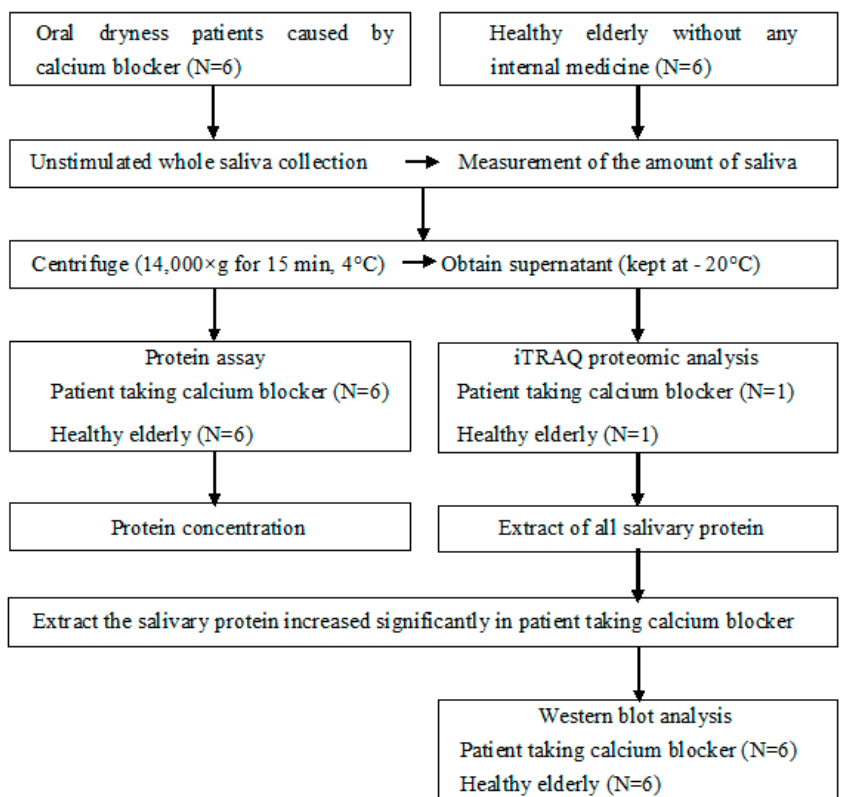
Figure 1. Protocol of this study. iTRAQ: Isobaric Tag for Relative and Absolute Quantitation.